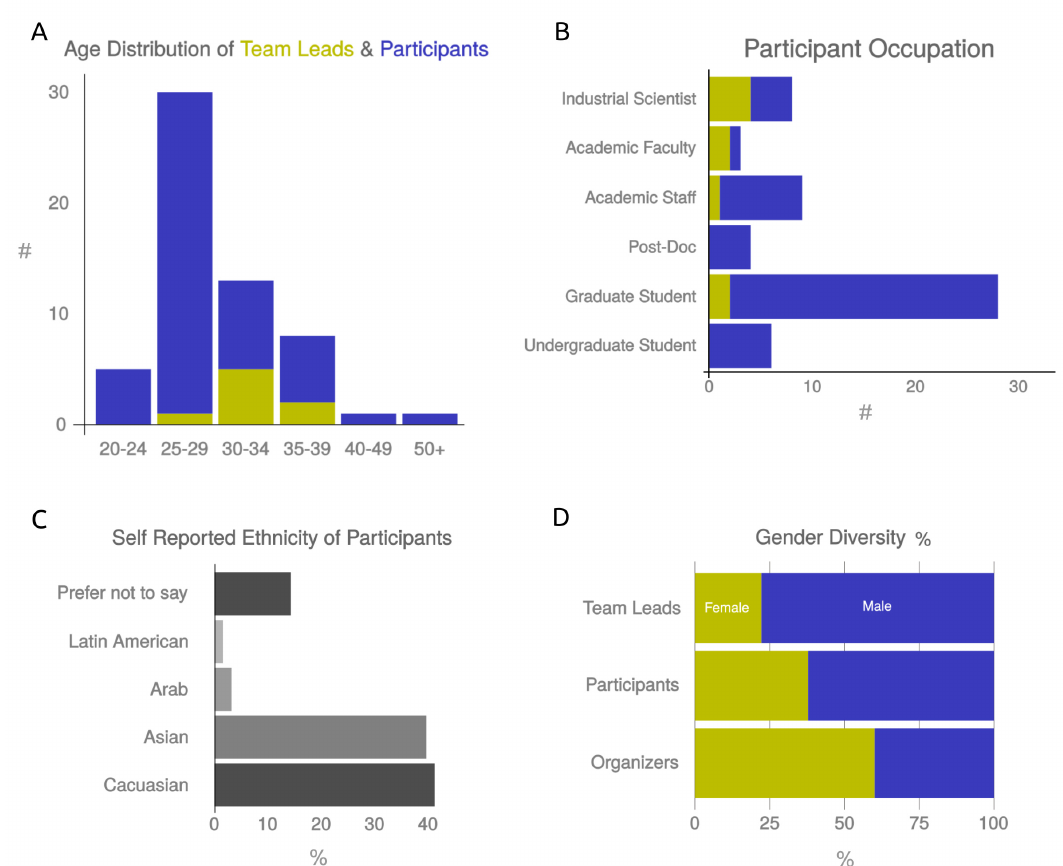
Figure 1. Participant diversity at hackseq 16. To measure diversity of hackseq participants, we asked team leaders and participants to self- report their ( A ) age, ( B ) current occupation, ( C ) ethnicity and ( D ) gender. Data is shown for team leaders (yellow) and participants (blue).